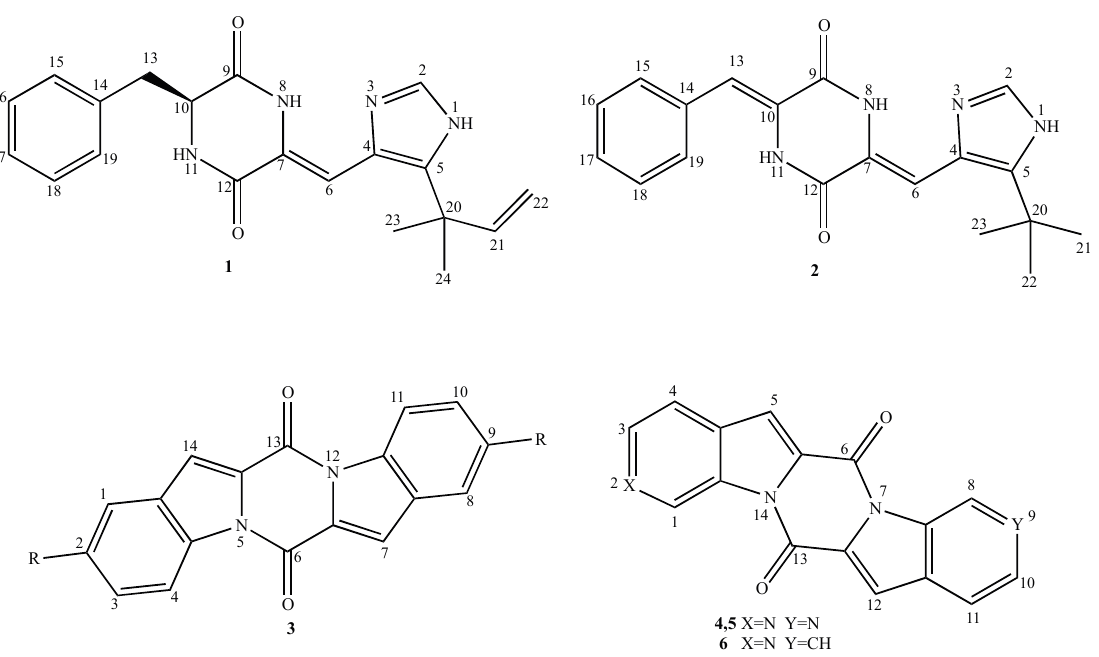
Figure 1. Chemical structures of diketopiperazine derivatives 1 ‒ 6